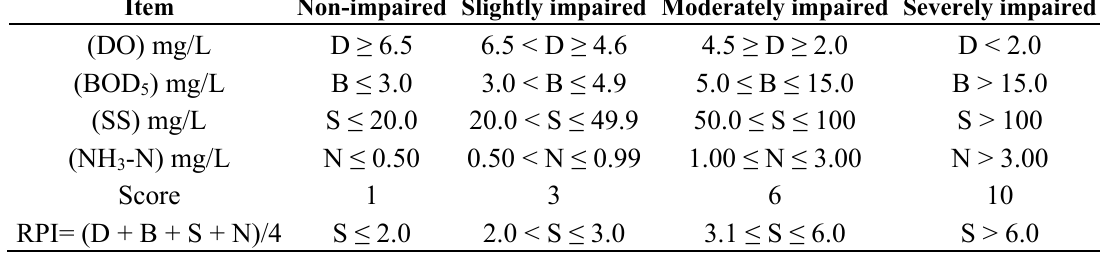
Table A1. River pollution index (RPI) using by EPA Taiwan, RPI under 2 Non-impaired, to severely